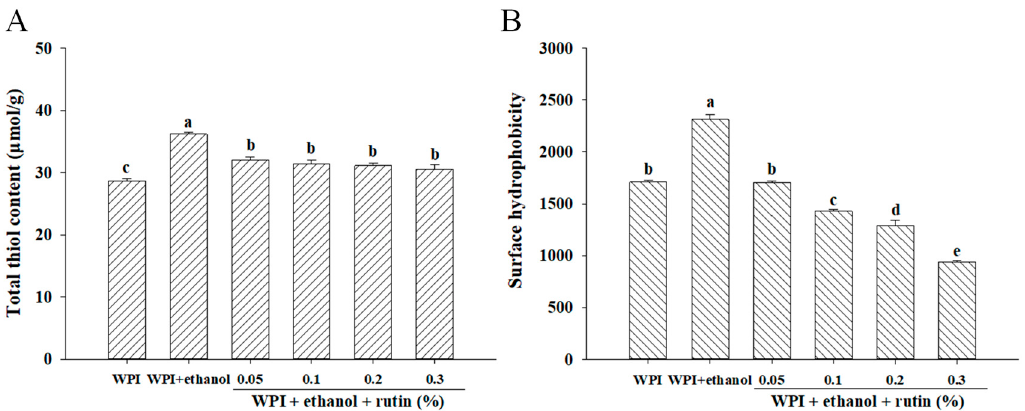
Fig. 2. Effects of ethanol (15%, v/v) and different levels of rutin (0.05%, 0.1%, 0.2% and 0.3%, Figure 2. The effects of ethanol (15% v / v ) and different levels of rutin (0.05%, 0.1%, 0.2% and 0.3% w / v ) on the total thiol content ( A ) and surface hydrophobicity ( B ) of WPI. Means with different letters (a–e) differ significantly ( p < w/v) on the total thiol content (A) and surface hydrophobicity (B) of WPI. Means with di ff erent letters (a–e) di ff er significantly ( P < 0.05).